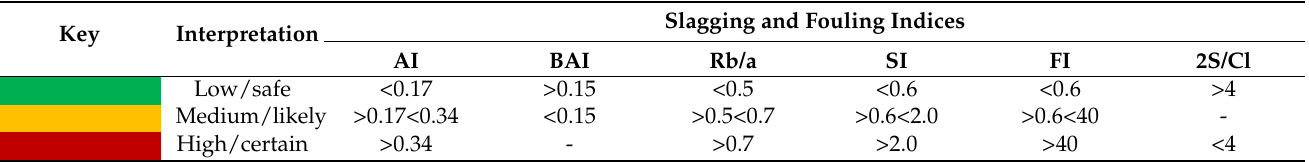
Table 1. Interpretation of predictive slagging and fouling indices